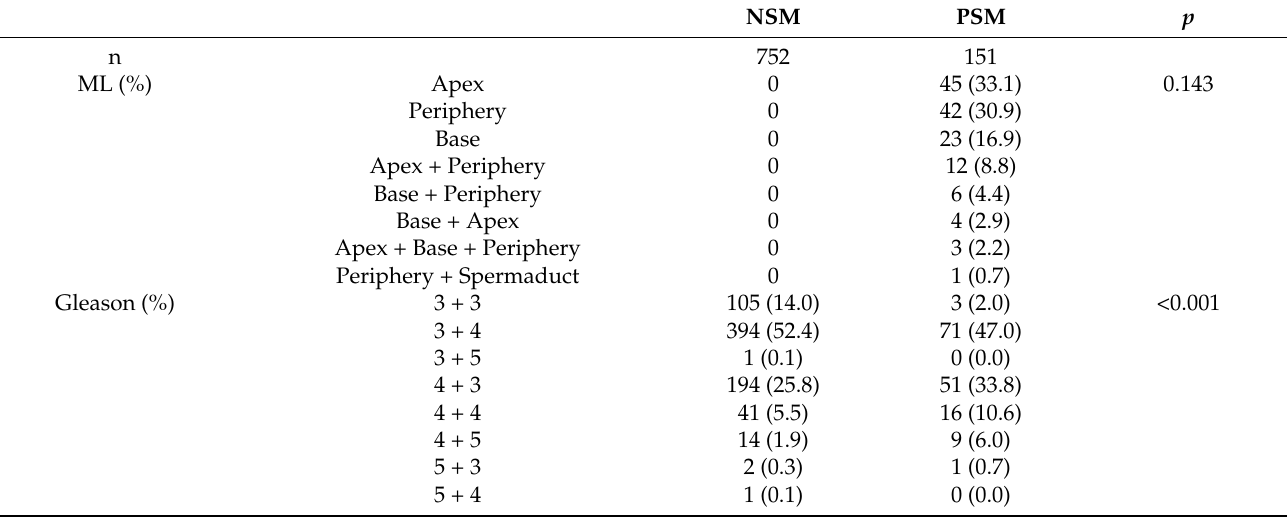
Table A1. Pathology